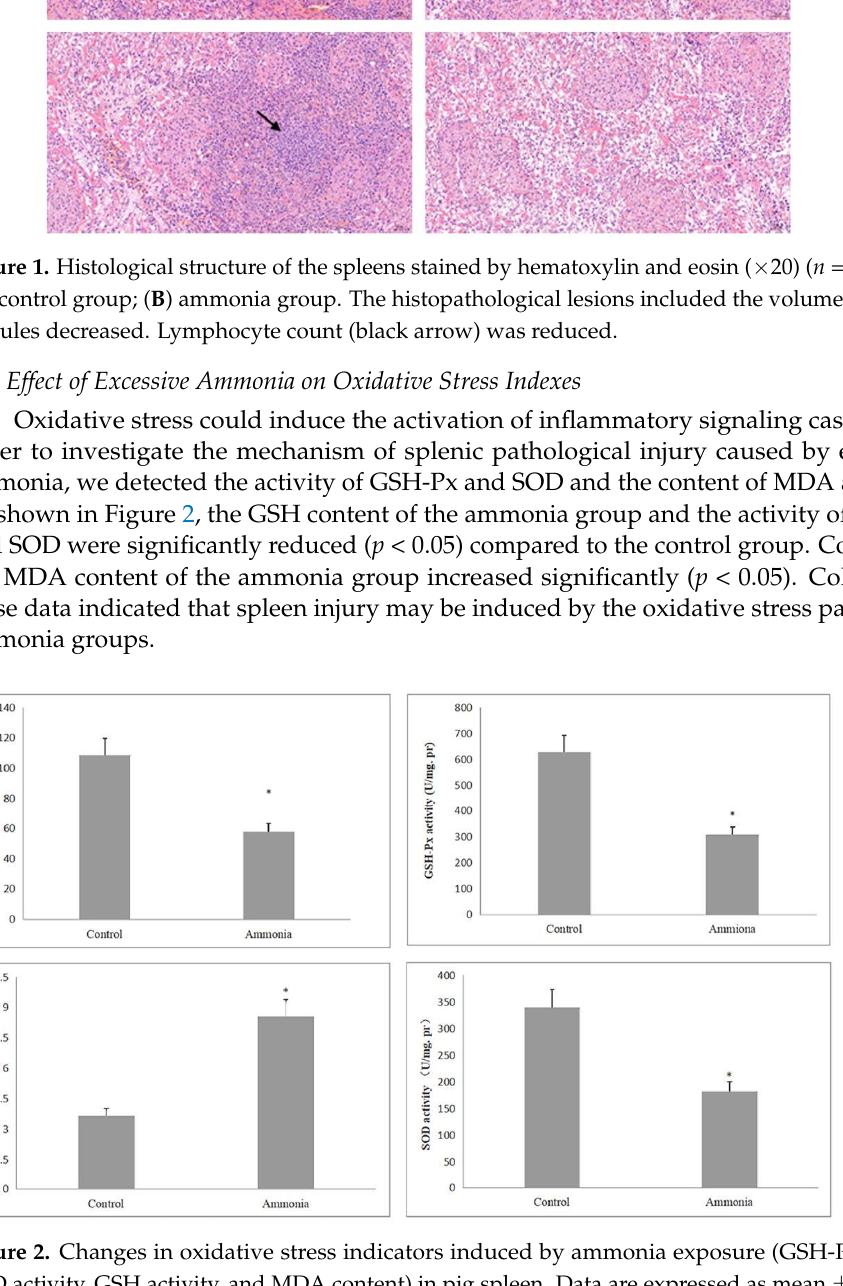
Figure 2. Changes in oxidative stress indicators induced by ammonia exposure (GSH-Px activity, SOD activity, GSH activity, and MDA content) in pig spleen. Data are expressed as mean ± standard deviation. * indicates a significant difference ( p < 0.05).